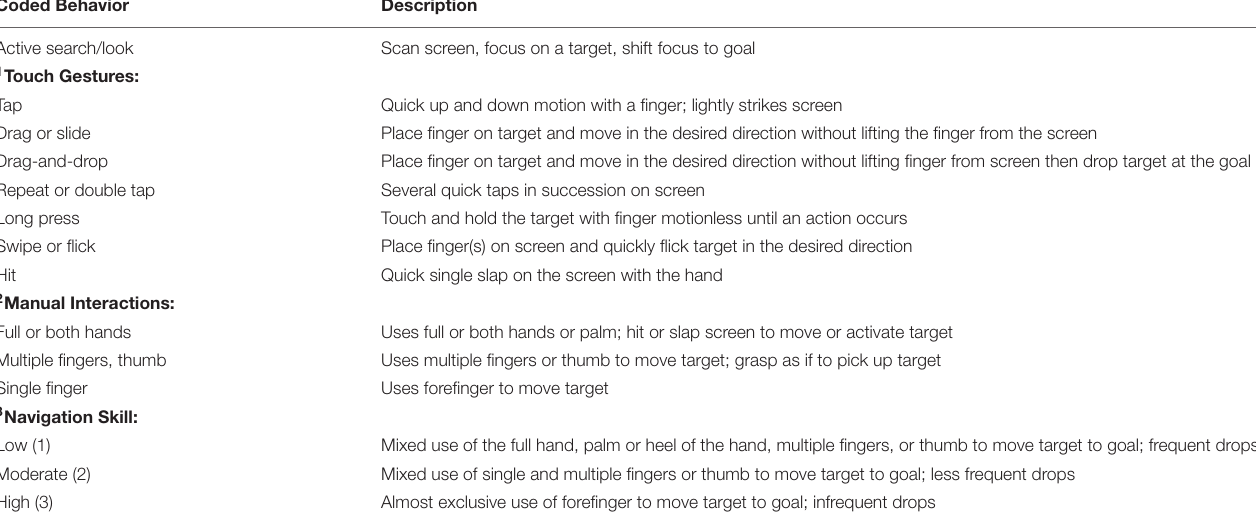
TABLE 1 | Coding scheme for children’s touch gestures, manual interactions, and navigational skill when using the shape matching and storybook apps. Coded